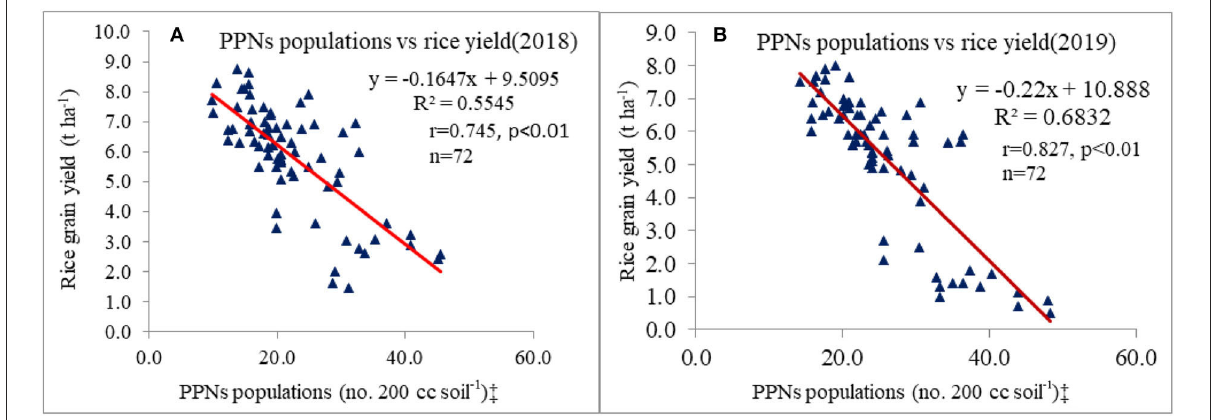
FIGURE3 Relationship between plant parasitic nematodes (PPNs) populations and rice grain yield (A) during 2018 and (B) during 2019. ‡ PPNs data were transformed through square-root (x 0.5) ½ method before correlation +